Question: What type of chart is this?
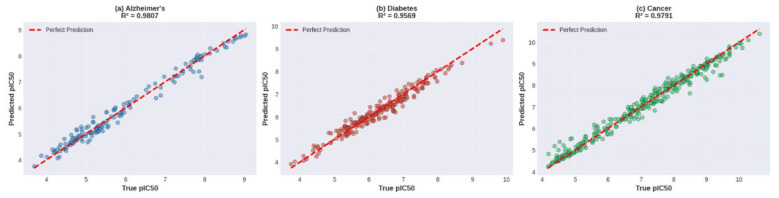
Answer: scatter